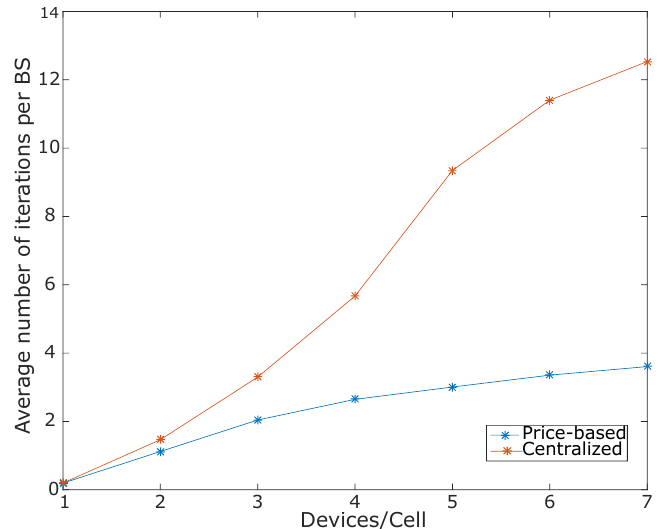
Figure 9. Average number of iterations required by each algorithm to solve the BS assignment